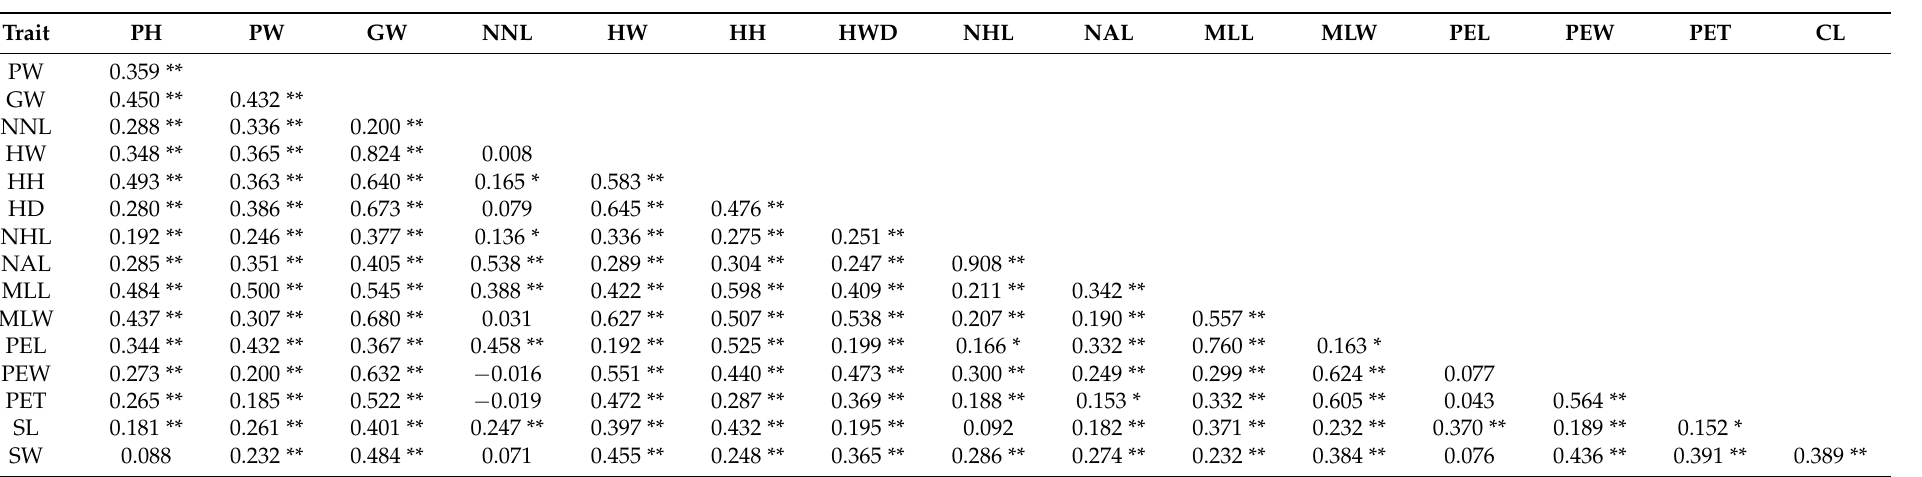
Table 4. Correlation co-efficient analysis of the 16 agricultural traits tested in the